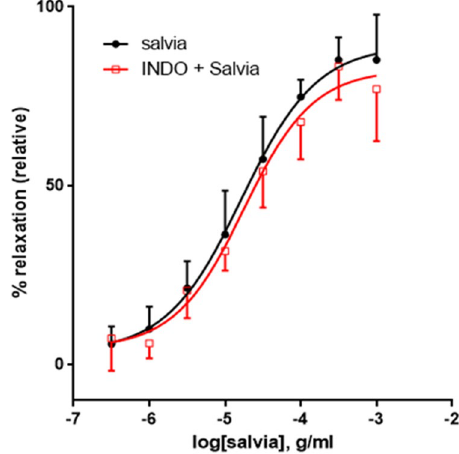
Figure 9. Role of cyclooxygenases in SF-induced relaxation of aortic rings. Endothelium-intact rings were incubated with cumulative doses of SF in the absence (Salvia; circles) or presence of indomethacin (10 µ M; Indo + Salvia; squares). Data represent mean ± SEM (n = 5; p > 0.05).